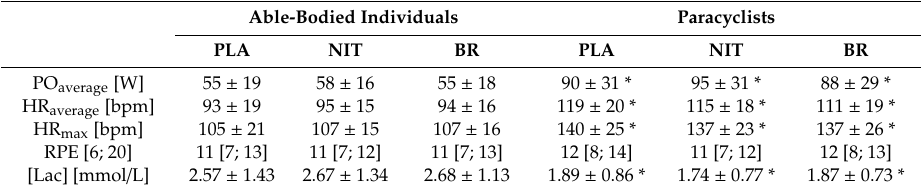
Table 4. Warm-up data for the two groups. Able-Bodied Individuals